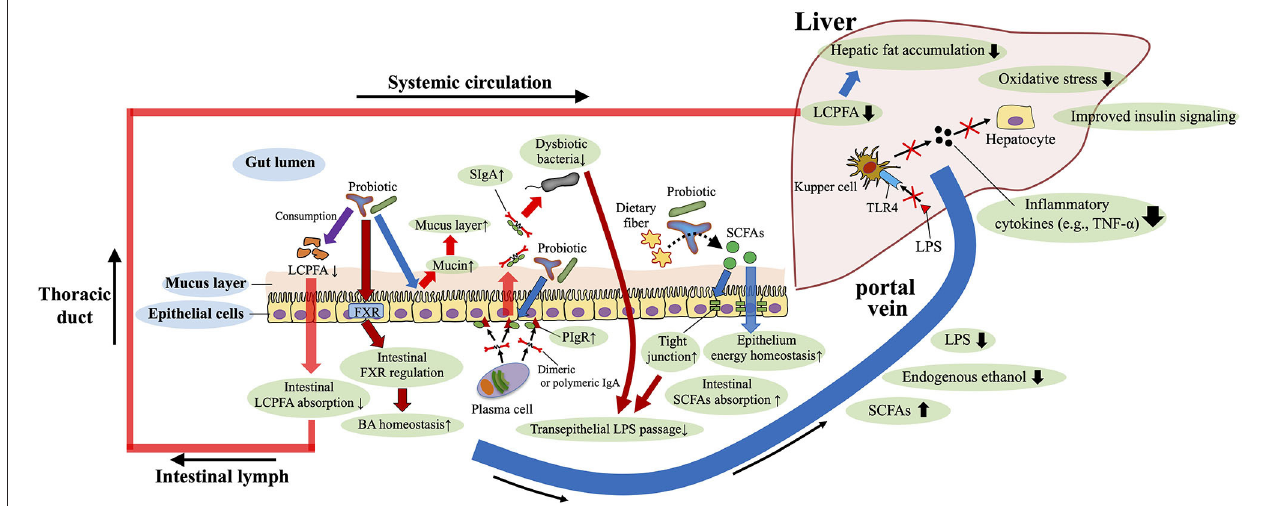
FIGURE 4 | Roles of probiotics against NAFLD. Probiotics enhance the barrier function of the gut [e.g., mucus layer, secretory IgA (SIgA) levels and tight junction tension], and improve the gut microbiota composition, bile acid (BA) homeostasis, and short-chain fatty acids (SCFAs) production. Restored gut barrier function and gut microbiota reduce portal transport of lipopolysaccharide (LPS), and therefore decrease LPS–toll-like receptor 4(TLR4) signaling-mediated inflammatory cytokine [e.g., tumor necrosis factor- α (TNF- α )] production in the liver. Probiotics also reduce intestinal absorption of long-chain polyunsaturated fatty acid (LCPFA) by consuming intestinal LCPFA. These beneficial roles of probiotics are involved in the underlying mechanisms of protection against NAFLD. PIgR, polymeric Ig recetor.